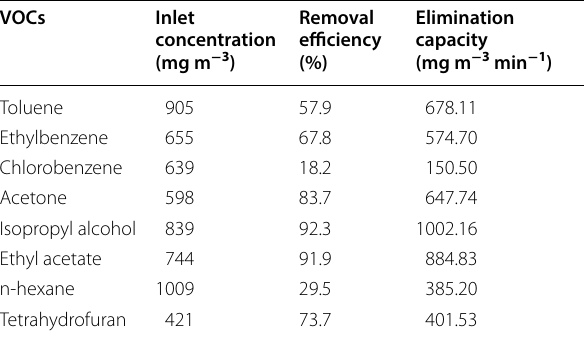
Table 1 Performances of the biofilter with different inlet VOCs VOCs